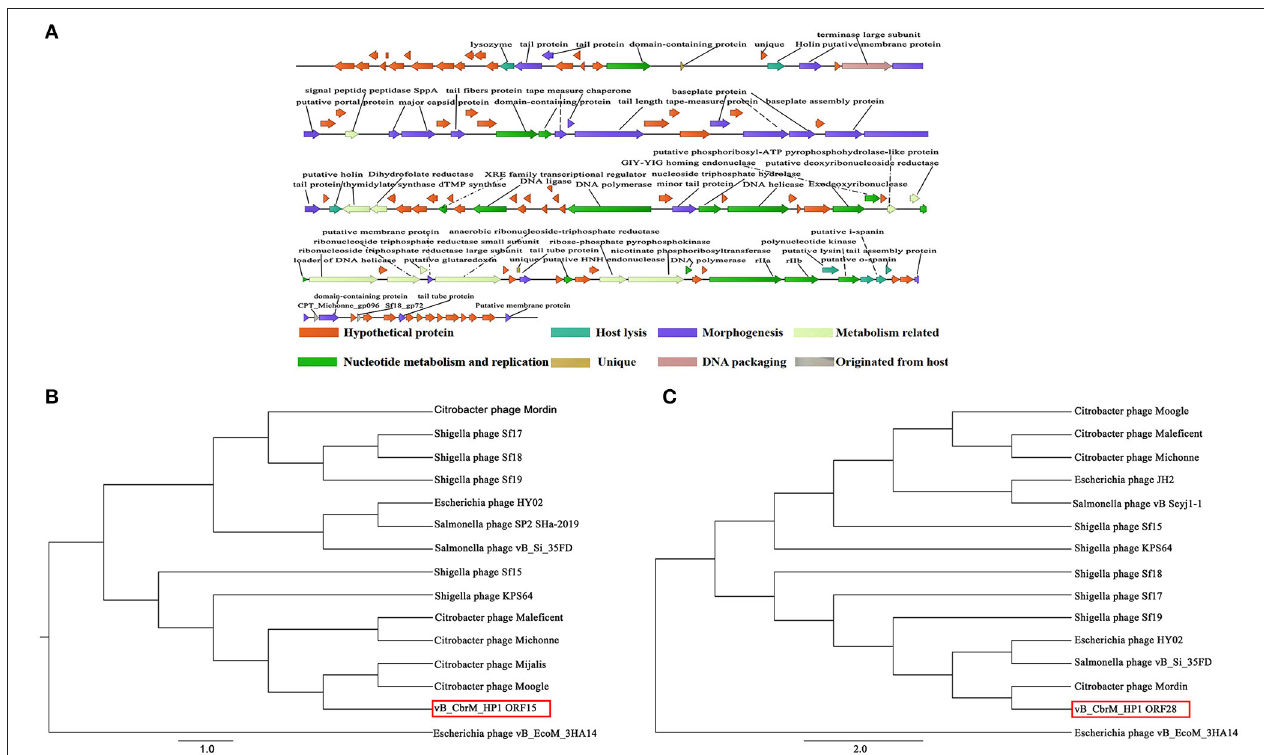
FIGURE 3 | Genome analysis of vB_CbrM_HP1. (A) The functional map of phage vB_CbrM_HP1. Each arrow represents an open reading frame (ORF); the direction of the arrow represents the transcription direction, and the functions encoded by the ORFs are annotated above. All encoded proteins were divided into eight modules, and each module is labeled with different colors. (B) Phylogenetic tree based on the lysome proteins. (C) Phylogenetic tree based on the terminase large subunits. The Clustalw program within BioEdit 7.0.4.1 was used for packaging. Based on the alignment results with the lysome and terminase large subunit gene sequences, the maximum likelihood (ML) phylogenetic tree was constructed using Phylip software (version